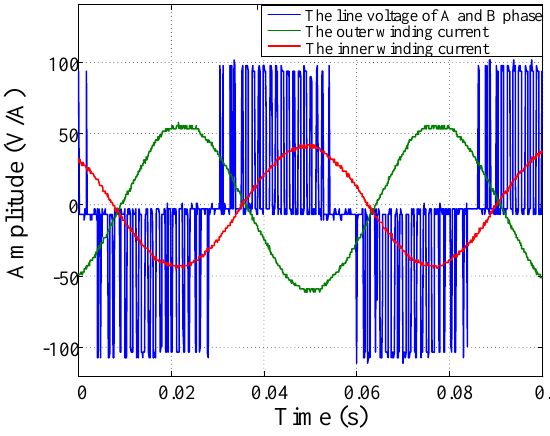
Figure 6. Experimental results of the VVVF control. Table 2. Test results of the VVVF